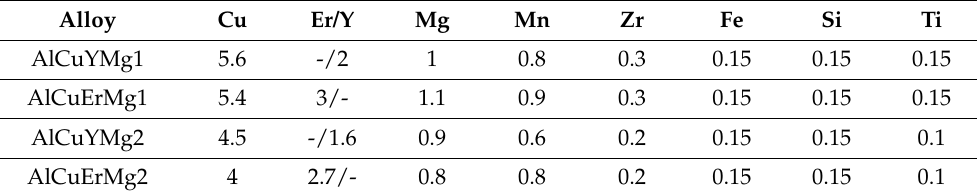
Table 1. Composition of the investigated